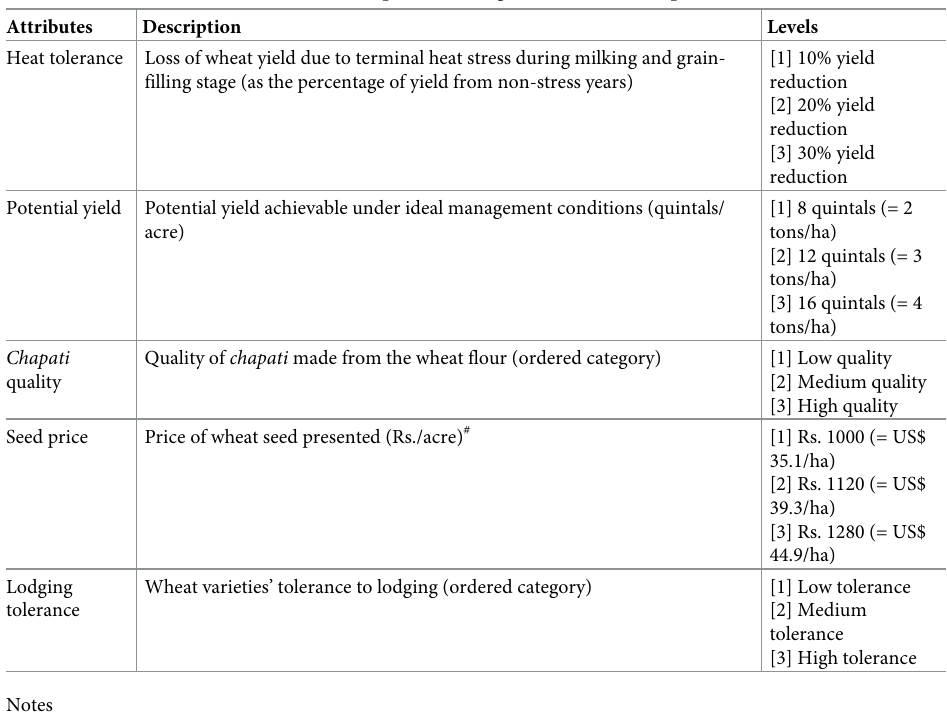
Table 1. Attributes and levels in the choice experiment design for wheat varietal